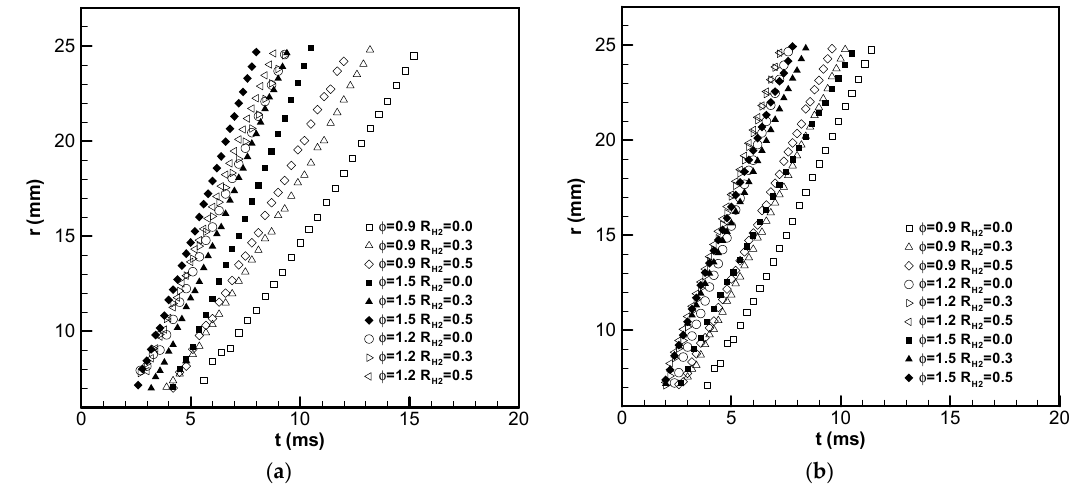
Figure 4. Effect of hydrogen addition on flame radius versus time. ( a ) T = 390 K; ( b ) T = 420 K.